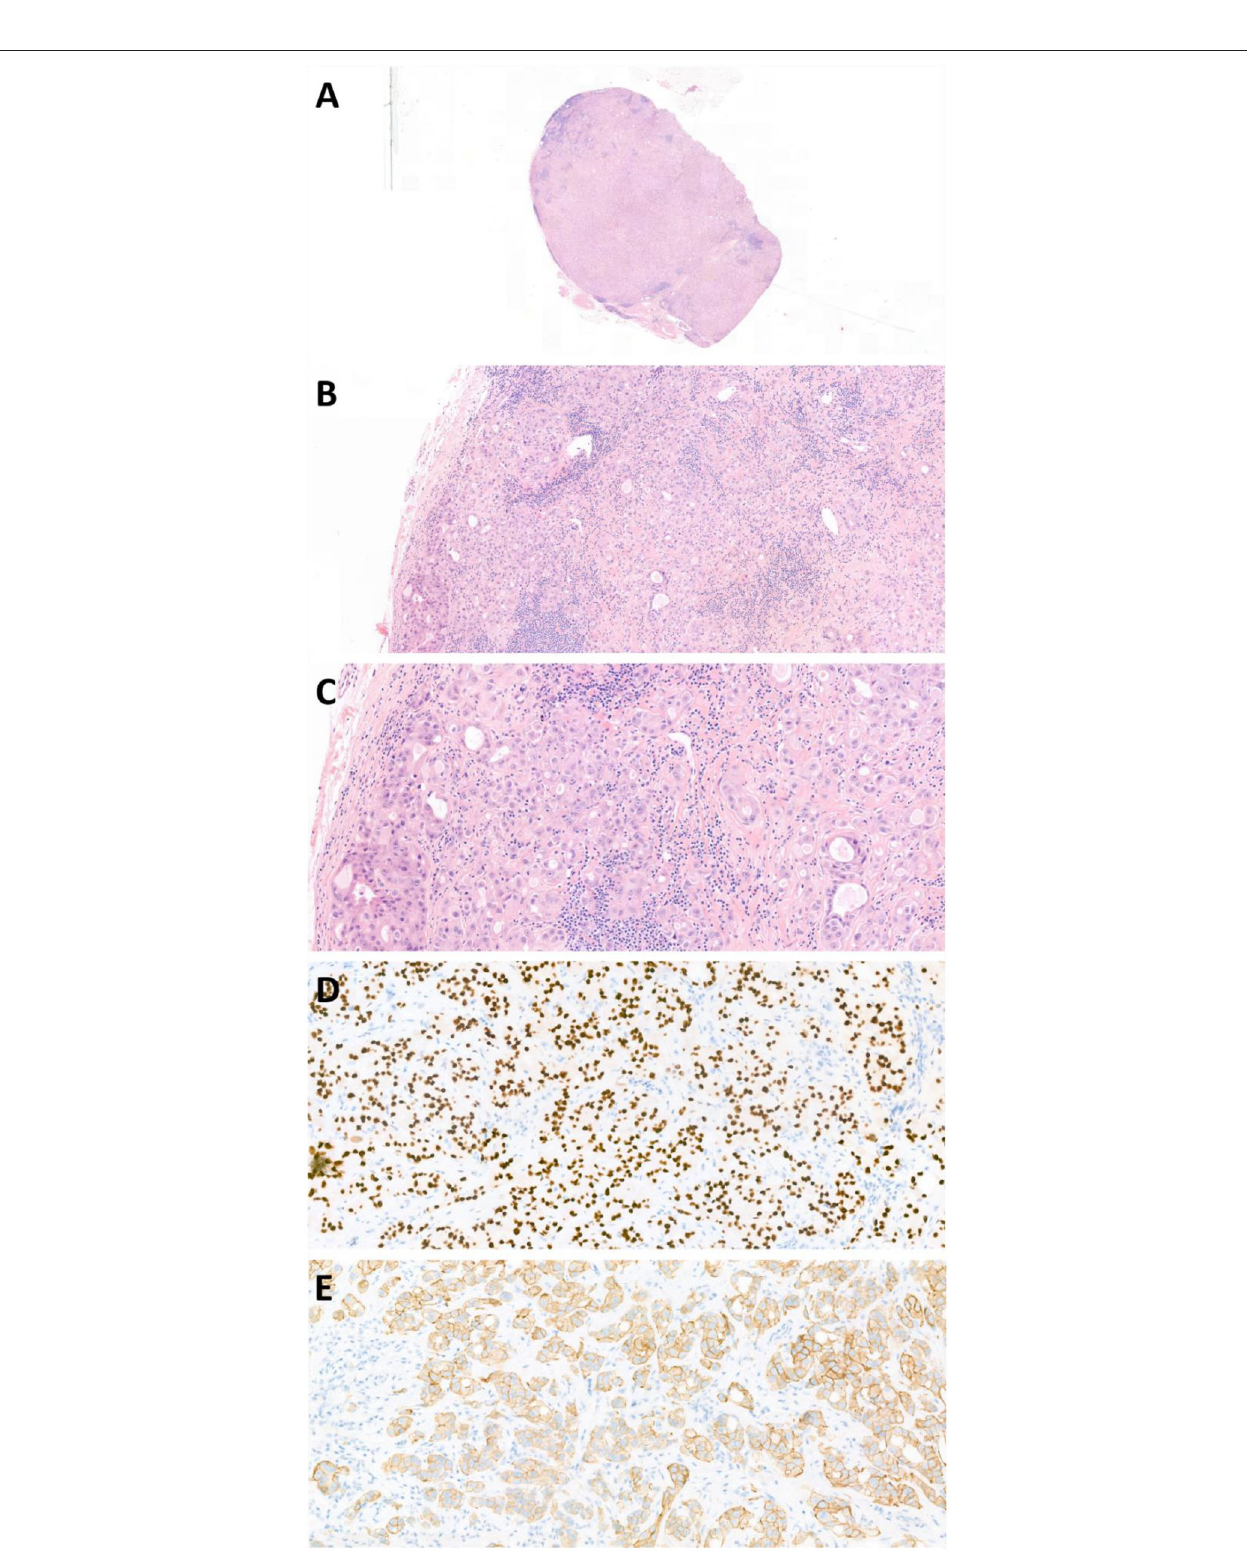
Frontiers in Medicine |